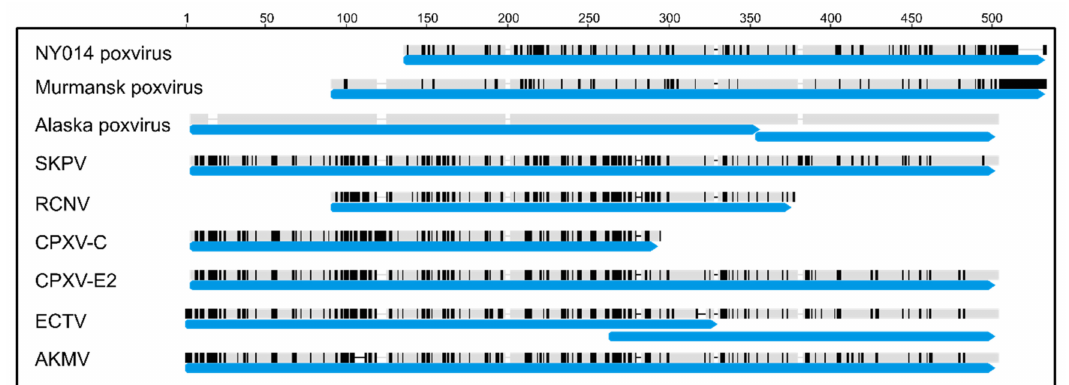
Figure 2. Alignment of C-type lectin genes from AKPV and reference OPXVs. Nucleotide identity to AKPV is shown by black or gray shading: identities are shown in gray, di ff erences in black. Black or gray bars indicate sequence, whereas black or gray horizontal lines indicate gaps. Blue arrows indicate the locations of annotated CDS. Alignment position is shown above the